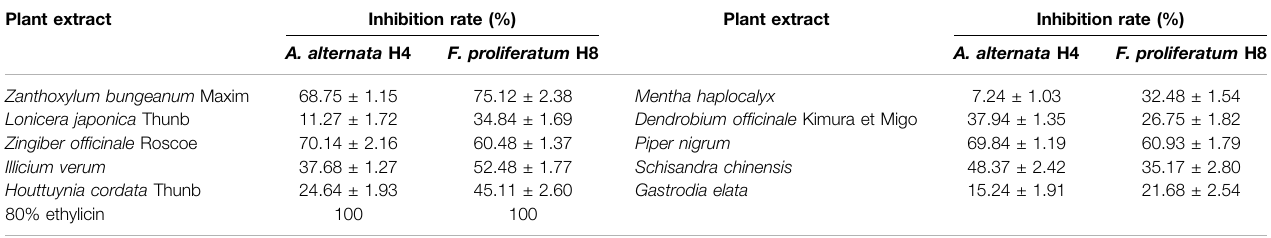
TABLE 3 | Determination of the inhibitory effect of 10 Chinese edible and medicinal plant extracts on A. alternata H4 and F. proliferatum H8. Plant extract